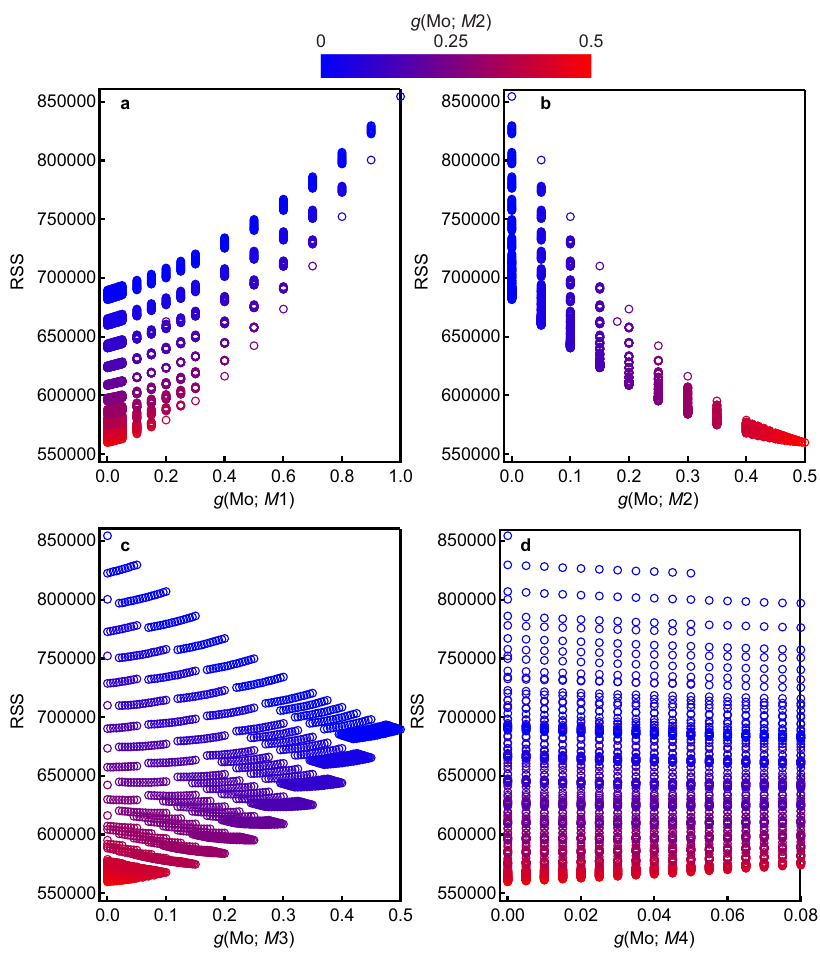
Fig. 4 | Determination of the Mo occupancy factors in Ba 7 Nb 4 MoO 20 ·0.15 H 2 O. Variation of the residual sum of squares (RSS; see the de fi nition of Eq. (3)) with the occupancyfactorofMoatomatthe a M 1, b M 2, c M 3and d M